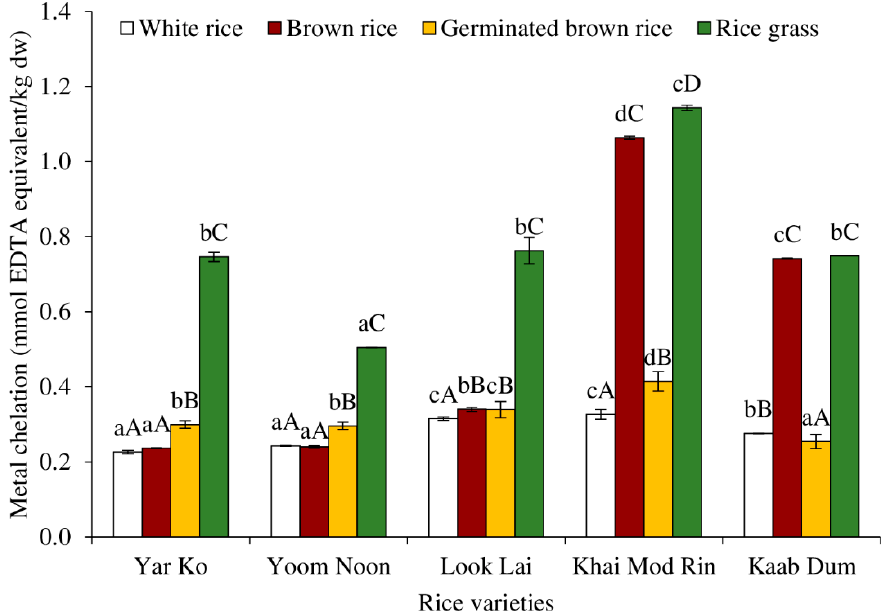
Figure 9. Effect of rice variety and processing condition on metal chelation of aqueous extract of Thai indigenous rice. Bars represent the standard deviations from triplicate determinations. Different lowercase letters within the same processing condition indicate significant differences ( p ˂ 0.05). Different uppercase letters within the same variety indicate significant differences ( p ˂ 0.05).